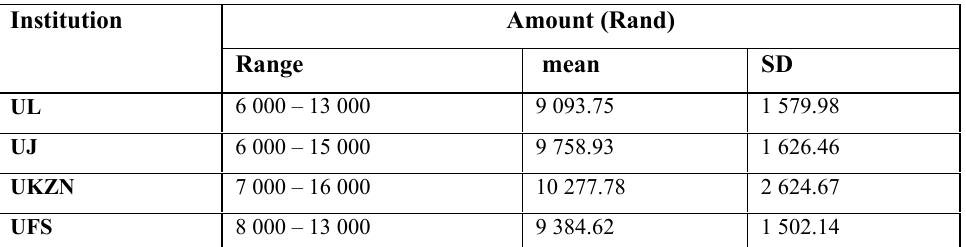
Table 10: The range, mean and standard deviation of the monthly salary that the respondents consider to be appropriate for a newly qualified optometrist employed in the public sector